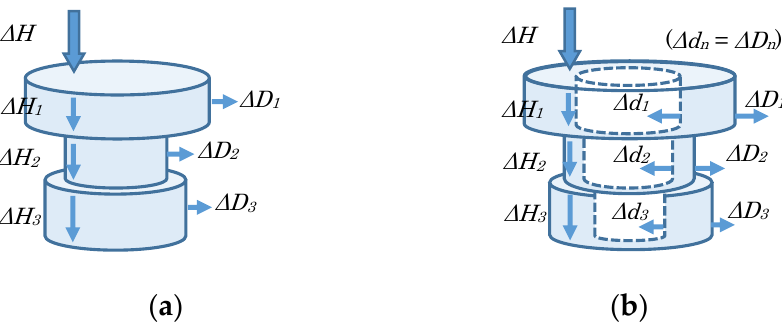
Figure 4. Reducing the total height: ( a ) in the case of a disk-type layer and ( b ) in the case of a ring-type